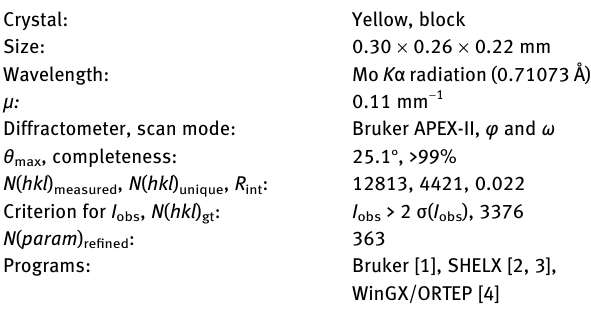
Table  : Data collection and